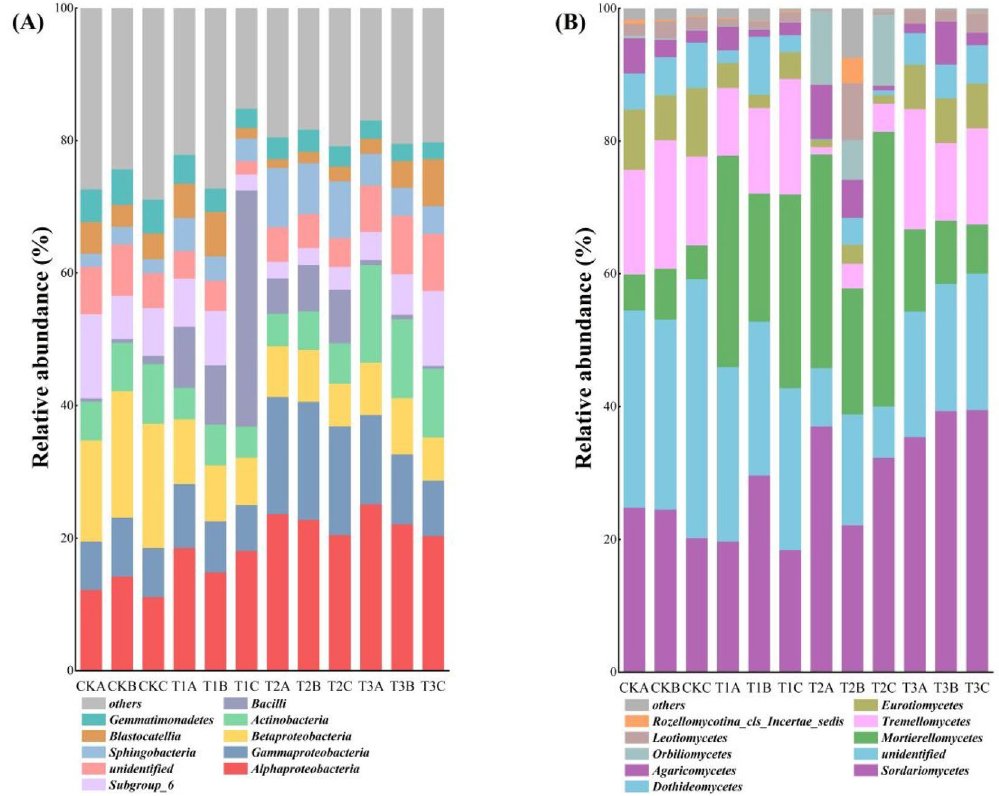
Figure 4. Bacterial (A) and fungal (B) classes community composition in different treated